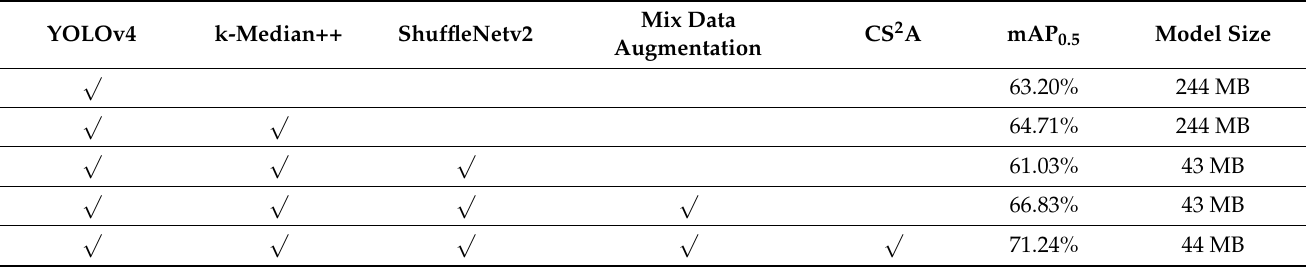
Table 6. Results of ablation